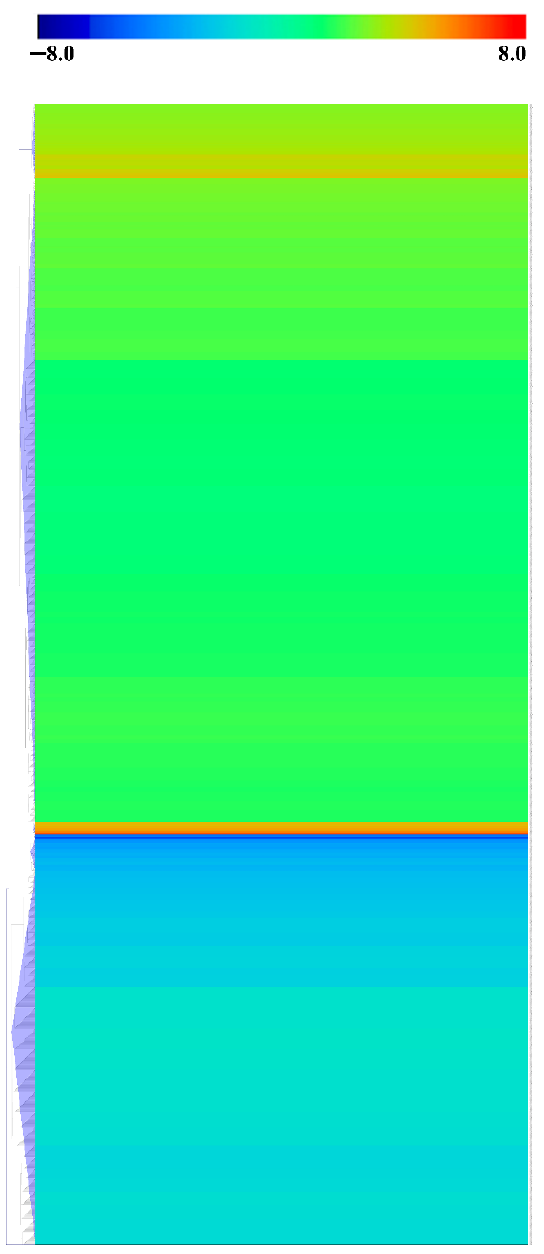
Figure 4. Hierarchical clustering analysis of DEPs. Log1.5 fold change value of DEPs is denoted by different colors.